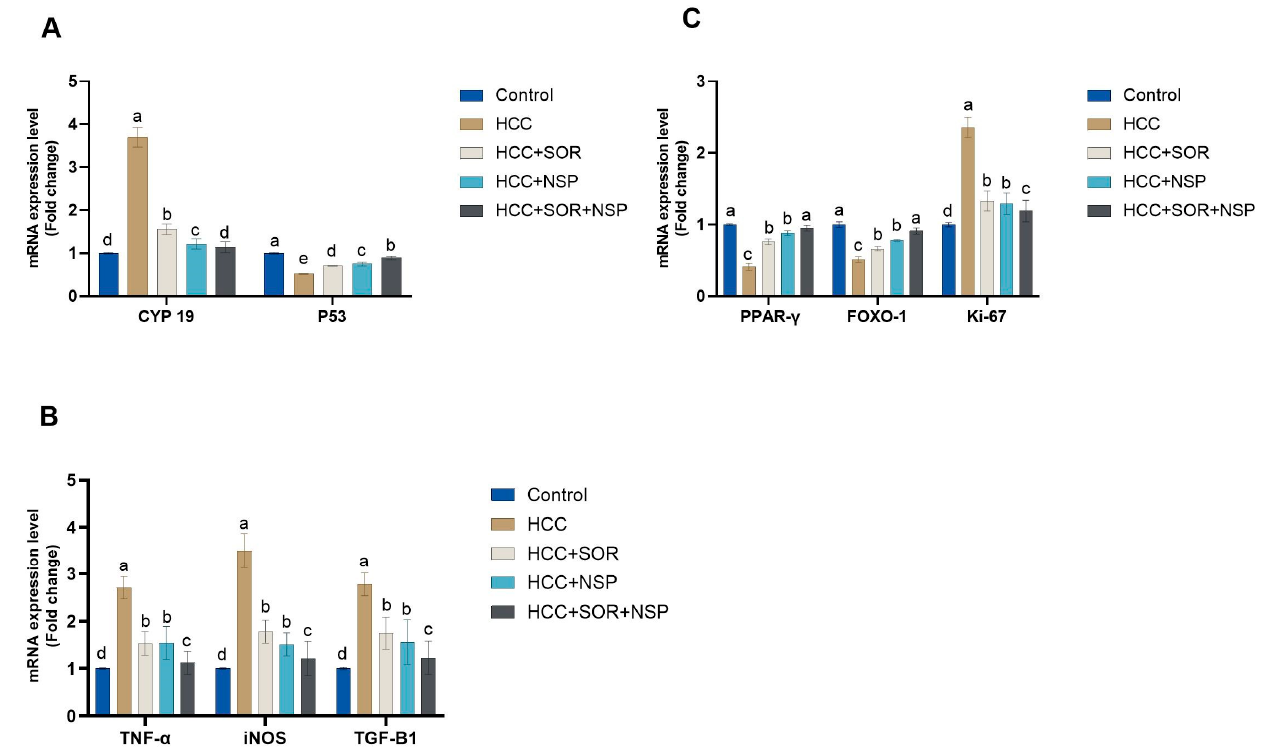
Figure 3. Effects of SOR, NSP, and their combination in DENA-induced HCC on the antioxidant status. ( A ) AFP; ( B ) CEA. Data are presented as the mean ± SE. a, b, c, d Mean values with different letters differ significantly at ( p ≤ 0.05). ( n = 8).